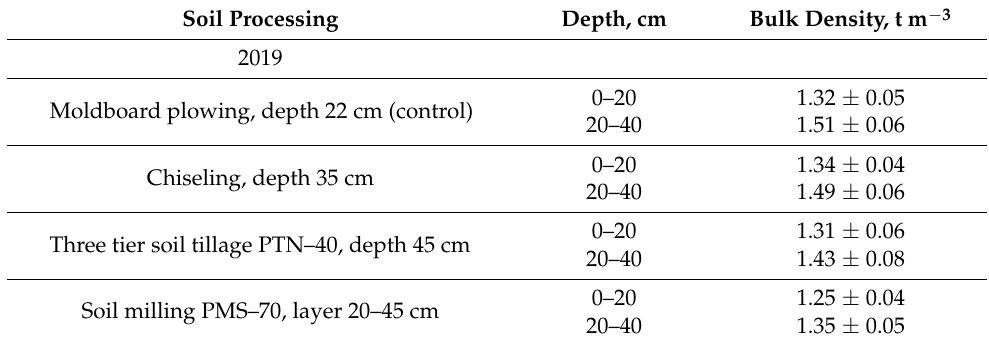
Table 4. Soil bulk density after different options of soil mechanical